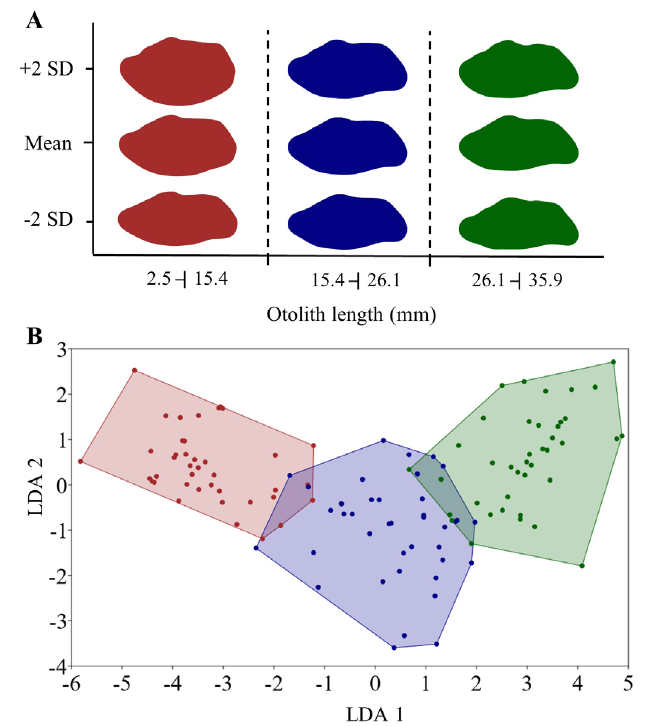
FIGURE 4 | Shape of otoliths of Centropomus undecimalis by morphotypes. A. Otolith mean outline and standard deviation (SD). B. Linear discriminant (LD) analysis of harmonics of elliptic Fourier descriptors of otoliths. red = Morphotype 1; blue = Morphotype 2; green = Morphotype